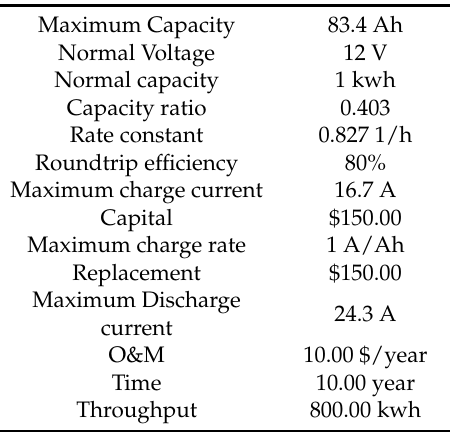
Table 3. Cost assumptions and specifications for